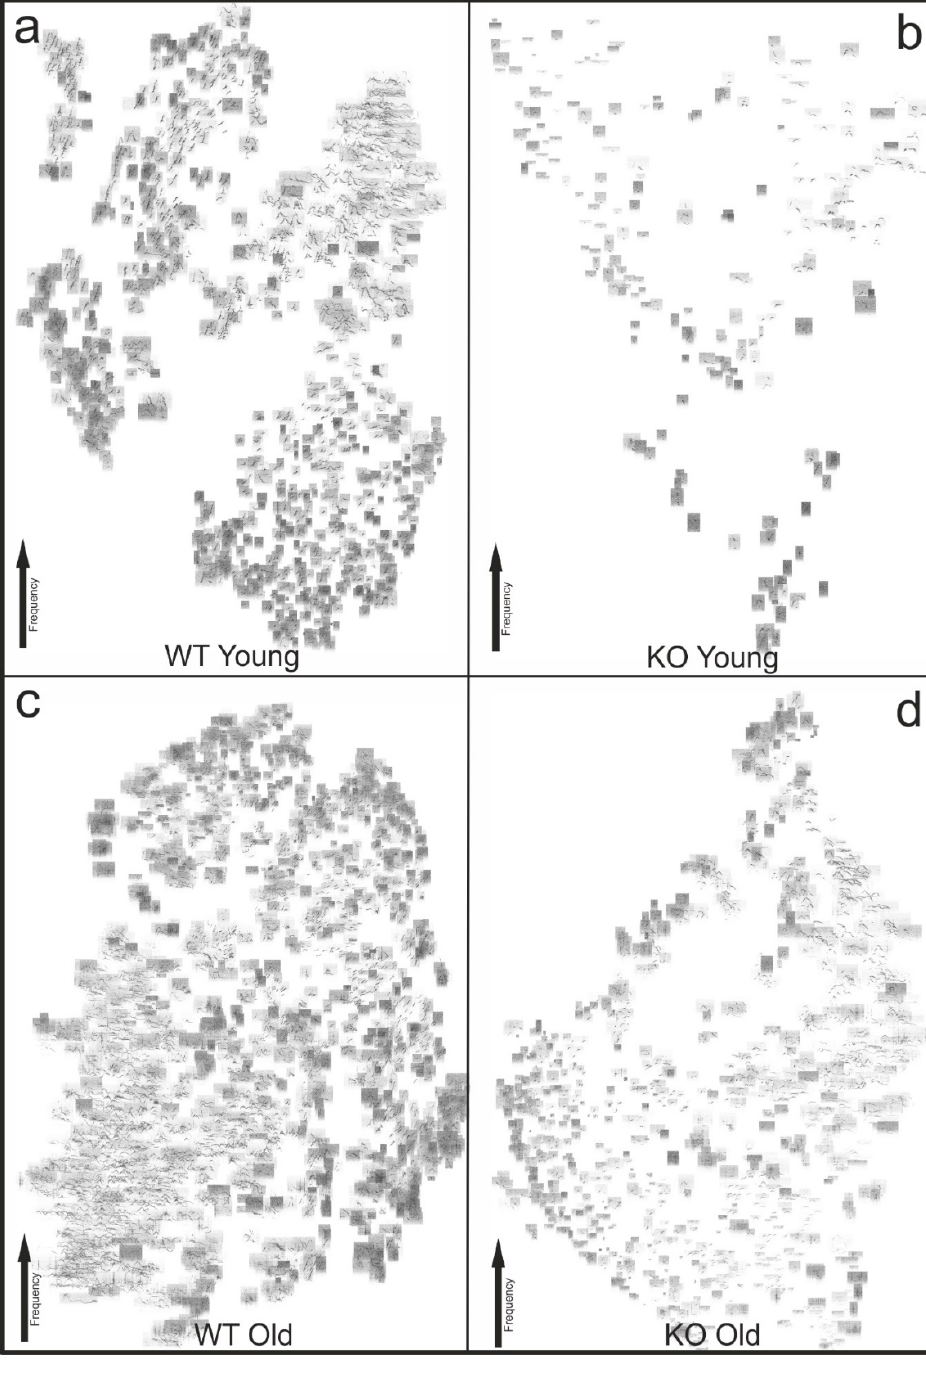
Figure 5. T-SNE plots of all four test groups. ( a ) T-SNE plot of all calls from young WT mice, plotted by frequency ( n = 1658). ( b ) T-SNE plot of all calls from young KO mice, plotted by frequency ( n = 238). ( c ) T-SNE plot of all calls from old WT mice, plotted by frequency ( n = 3326). ( d ) T-SNE plot of all calls from old KO mice, plotted by frequency ( n = 1271).